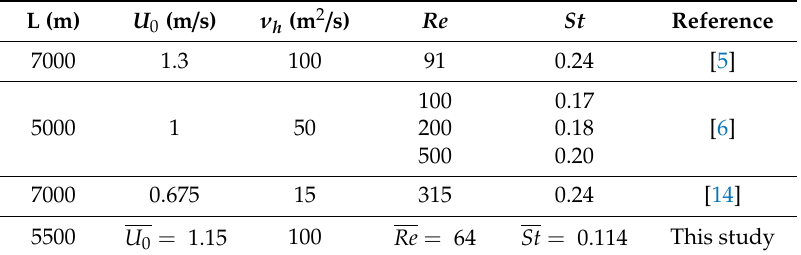
Table 1. Corresponding values for each point in Figure